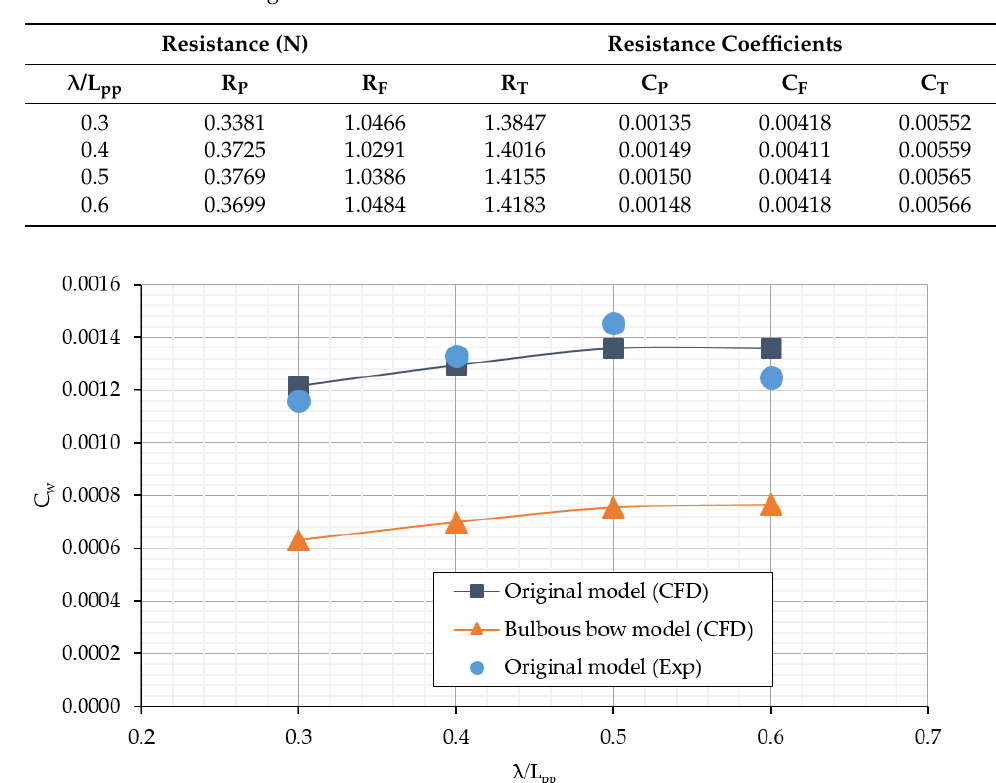
Figure 12. Added wave resistance coefficients of the ships under wave conditions, H w = 0.02 m at F n = 0.163.